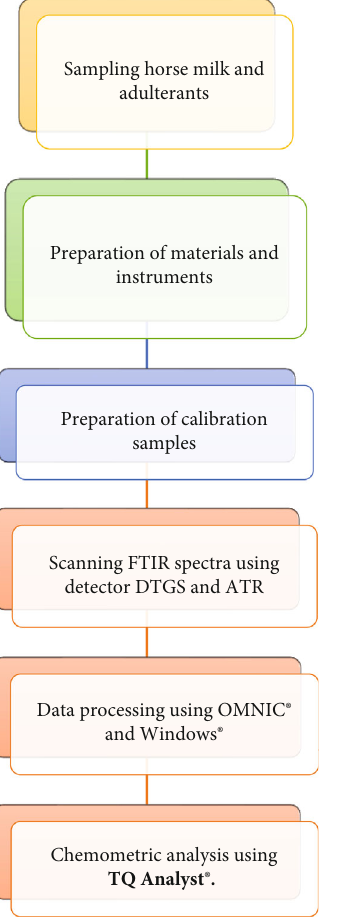
Figure 1: Flow chart for the authentication analysis for horse ’ s milk using FTIR spectroscopy and chemometrics.